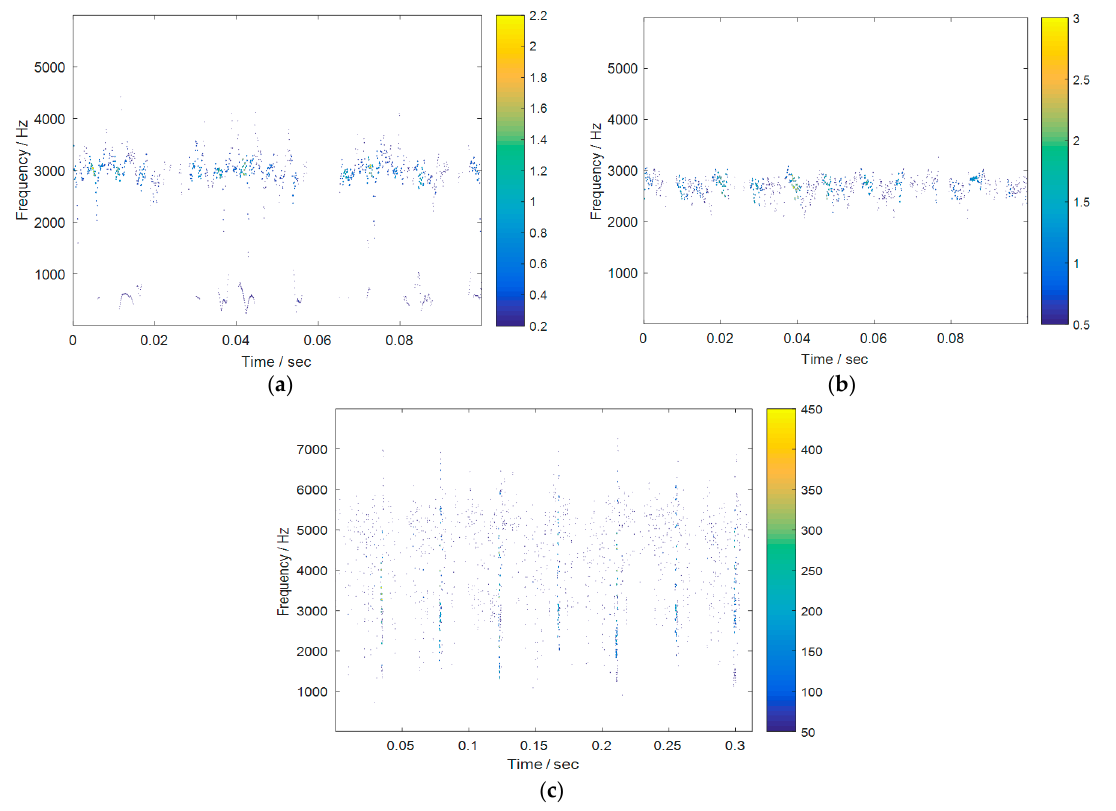
Figure 9. Time-frequency analysis of the signals in Figure 6 by the Empirical Mode Decomposition (EMD): ( a ) Inner race fault—EMD; ( b ) Outer race fault—EMD; ( c ) Gear tooth fault—EMD.